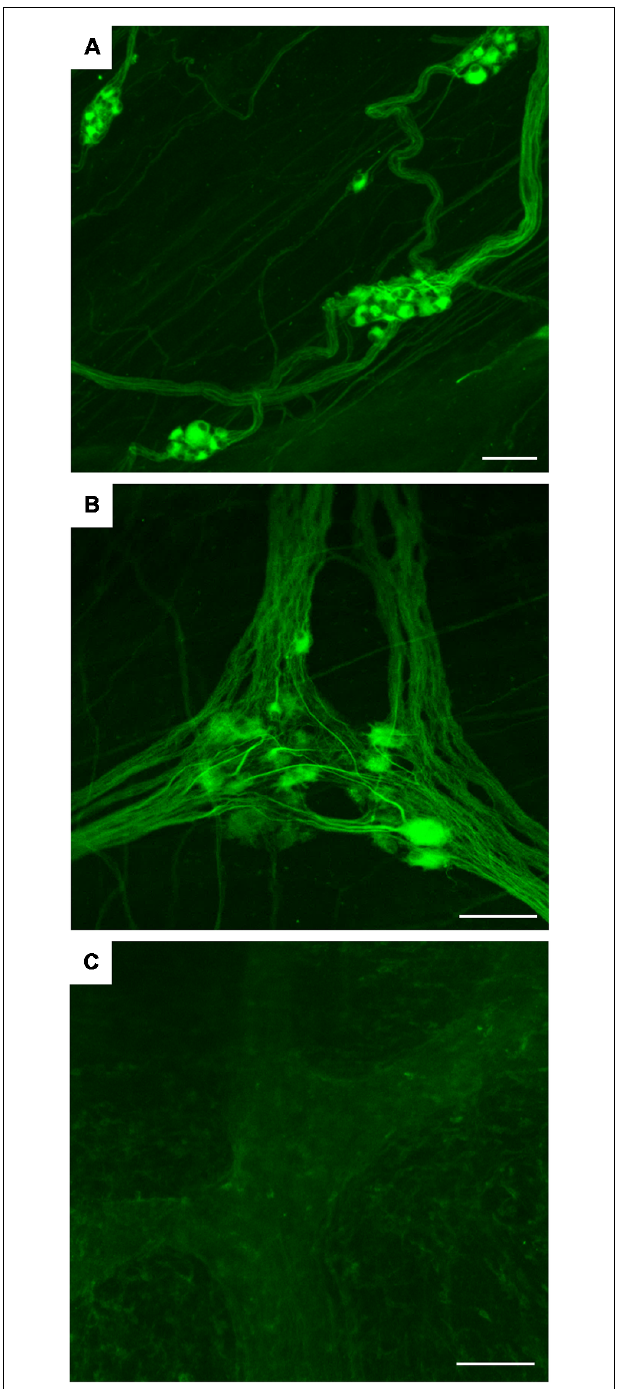
FIGURE 9 | Whole mount preparations of human sigmoid colon. IF using hpChAT antiserum (A,B) and vehicle alone (C) ; inner submucosal plexus (A) and longitudinal muscle/myenteric plexus (B,C) . The results, being consistent with those in thin cryostat sections ( Figures 5 – 8 ), indicate that the method using thick tissues will help to improve our understanding of three-dimensional organizations of structures stained with hpChAT antiserum. No specific staining is seen in the control processed without hpChAT antiserum (C) . Bars = 100 µ